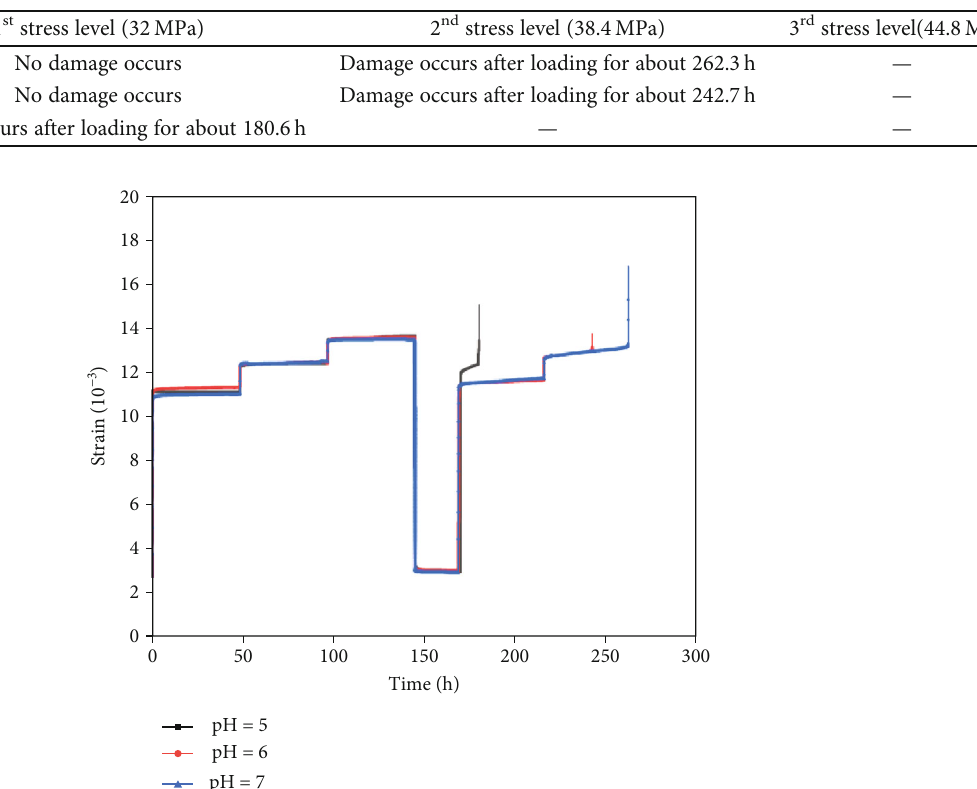
Figure 9: Comparisons of the mass changes with di ff erent saturations. Table 1: Creep damage of gypsum rocks under di ff erent situations.